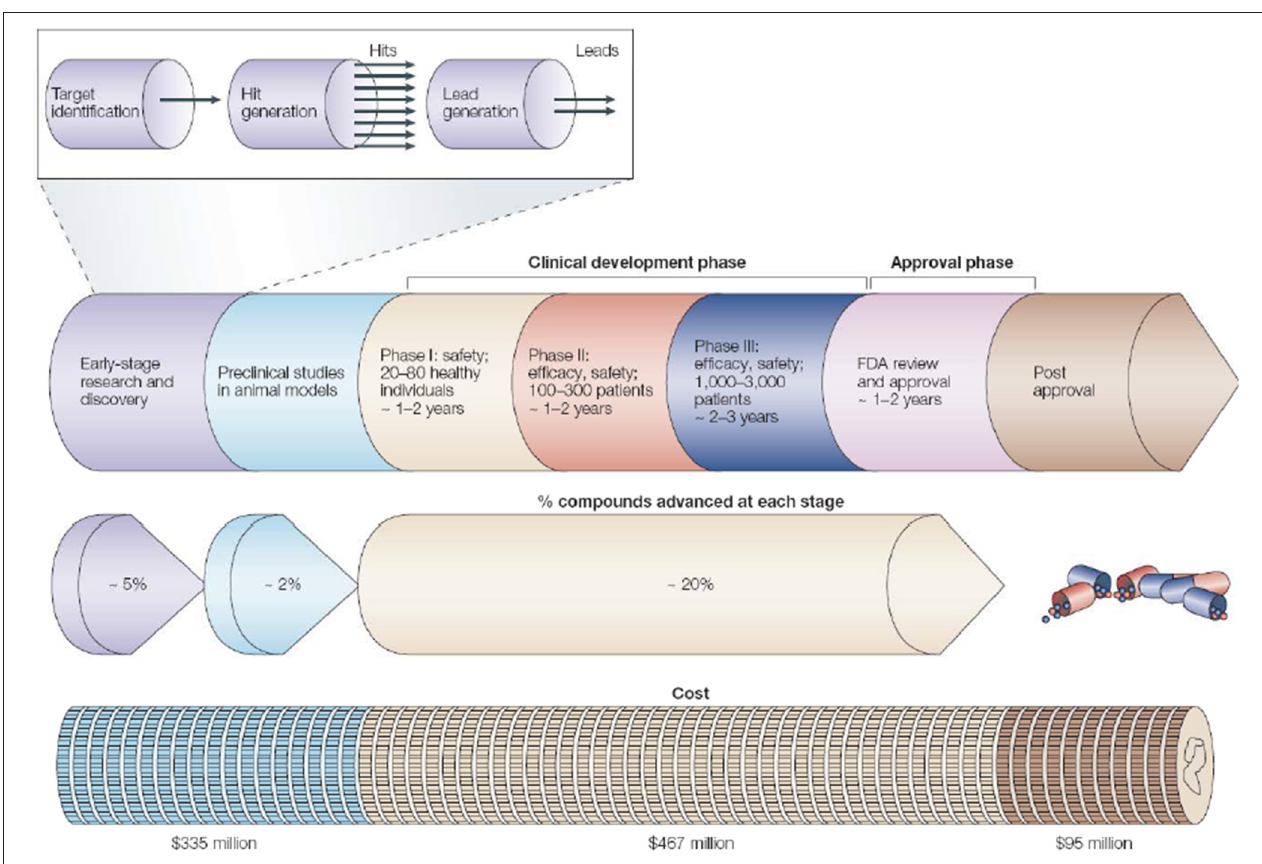
FIGURE 3 | The pipeline for drug discovery and development. The long process starting from initial idea to a marketed drug takes ∼ 12–15 years and success rate of finally reaching 1 in 5,000 compounds to the market (may vary depending on the disease area). The preclinical stage gives most failures so need to detect it as early as possible. Pipeline follows hit-to-lead process by assessing “hits” for relevant biological and drug-like properties (Reprinted by permission from Macmillan Publishers, Ltd.: Nature Horizon, ref. [110], copyright